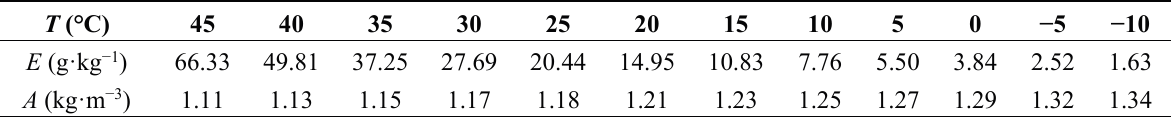
Table 7. Air density ( A ) and saturation mix ratio ( E ) of water vapor to air for various air temperatures ( T